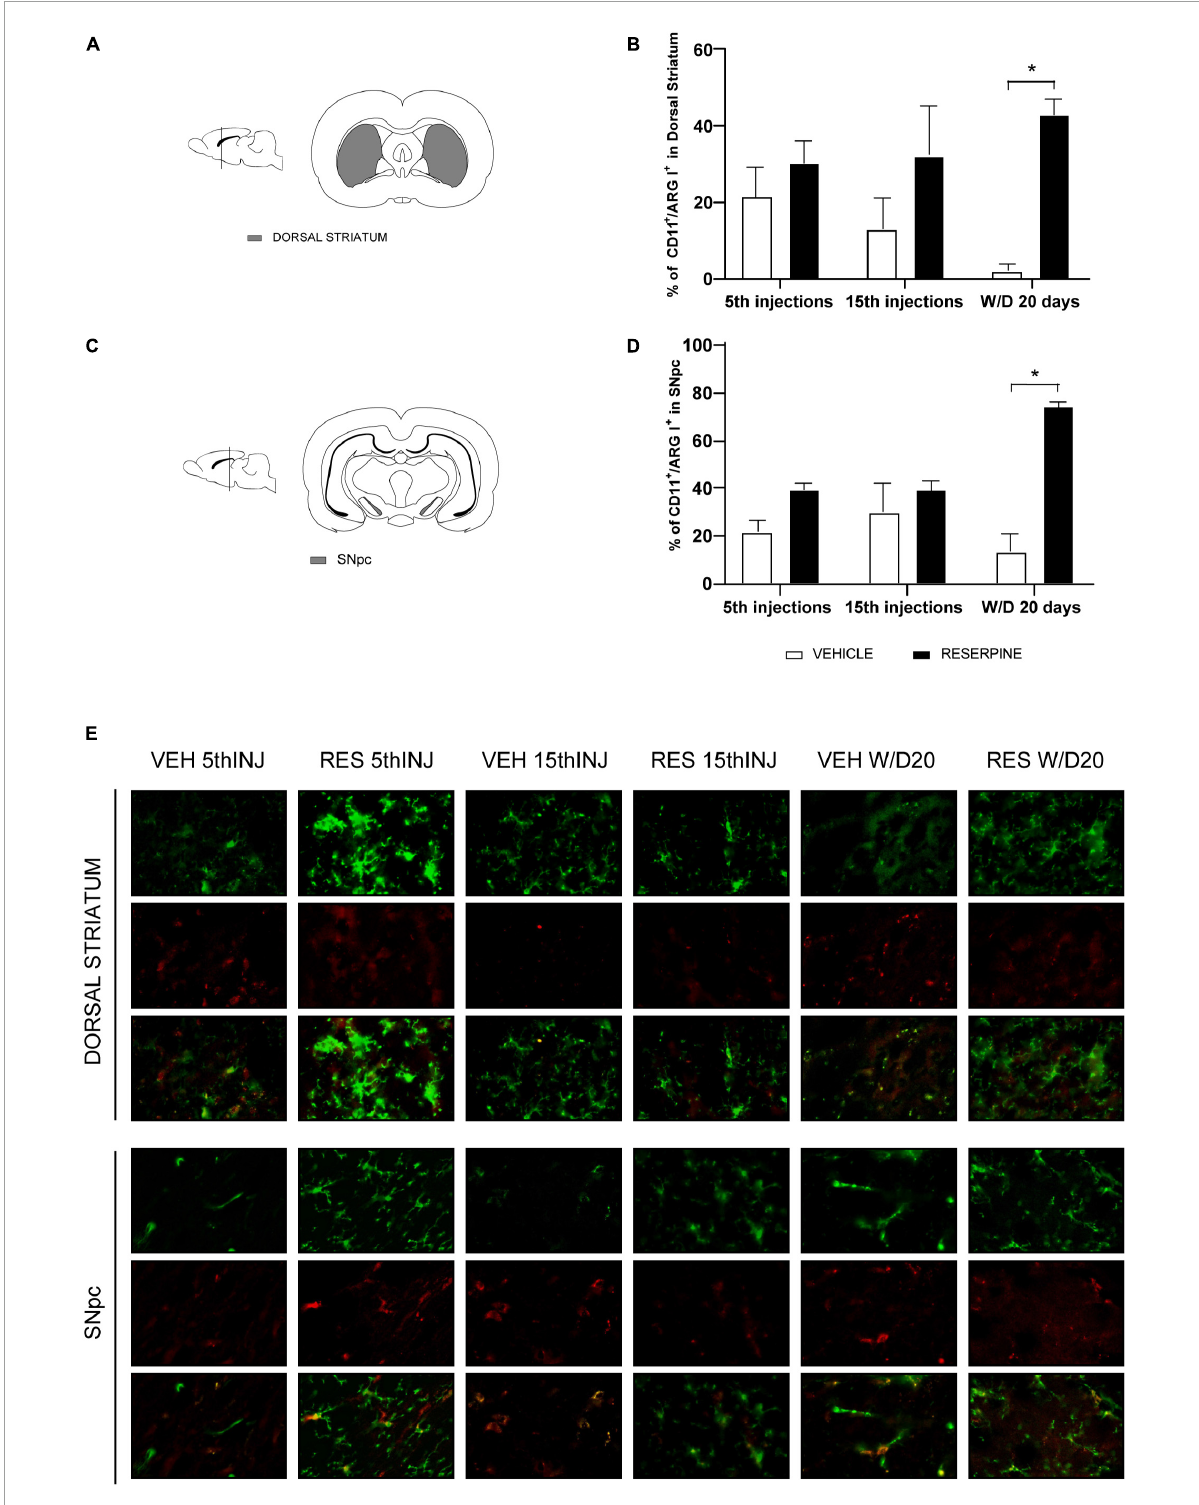
FIGURE8 Coronal slice scheme of Dorsal Striatum (A) and SNpc (C) ; effects of repeated administration of 0.1 mg/kg reserpine ( n = 3) on immunofluorescence with double labeling for CD11b (green) and ArgI (red) expressed by percentage of CD11 + /ArgI + cells in Dorsal Striatum (B) and SNpc (D) ; and representative photomicrographs of immunofluorescence in SNpc coronal sections and Dorsal Striatum (E) . Data are shown as mean + SEM, * p < 0.05 comparing Reserpine and Vehicle groups (ANOVA followed by Sidak’s test). Magnification